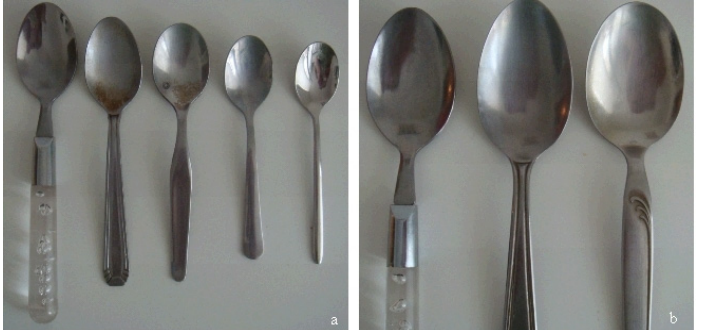
Figure 3. Example of different spoons household (a: tea spoons; b: table